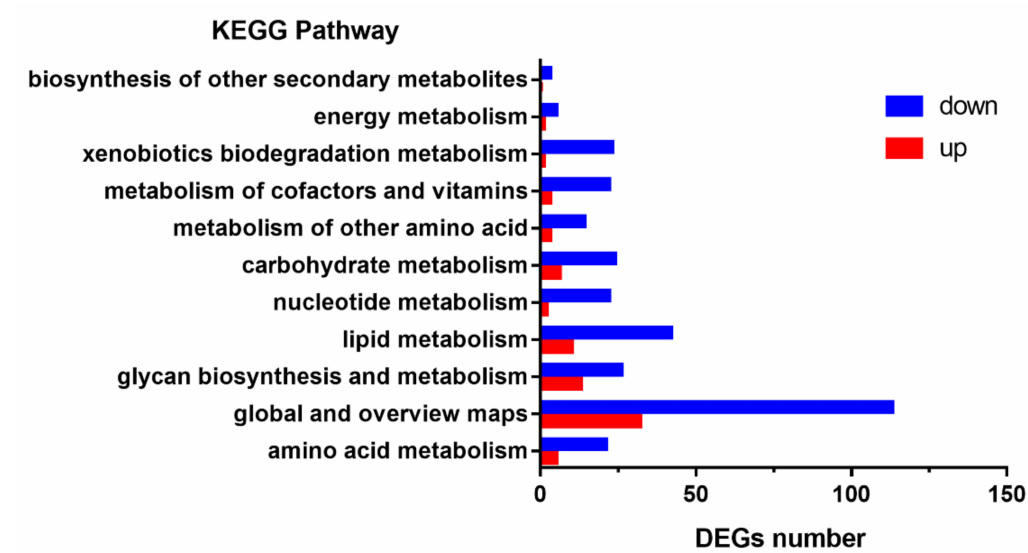
Figure3. Kyotoencyclopediaofgenesandgenomes(KEGG)enrichmentanalysisofDEGsinmetabolism pathways. The y-axis indicates pathways and the x-axis indicates the number of DEGs. The red bar shows the upregulated genes and the blue bar shows the downregulated